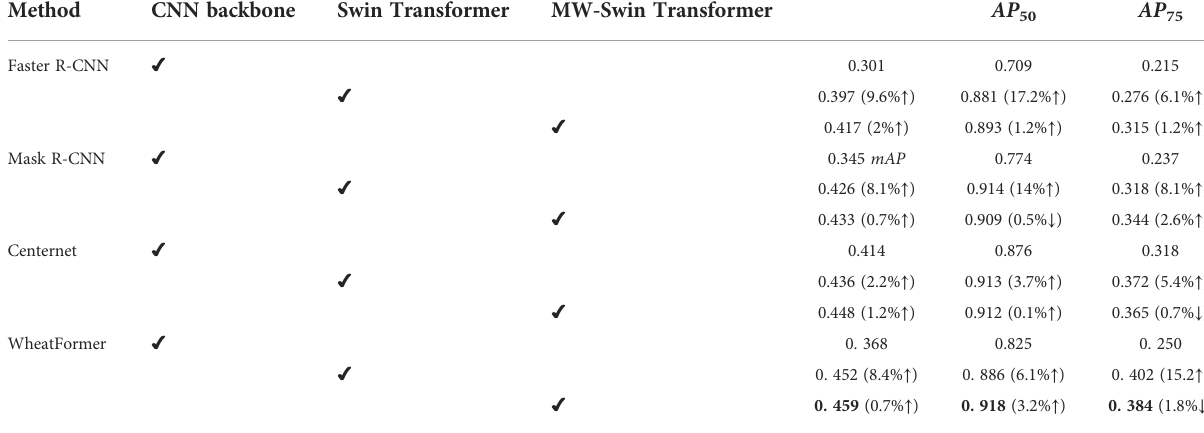
TABLE 4 Comparison of different